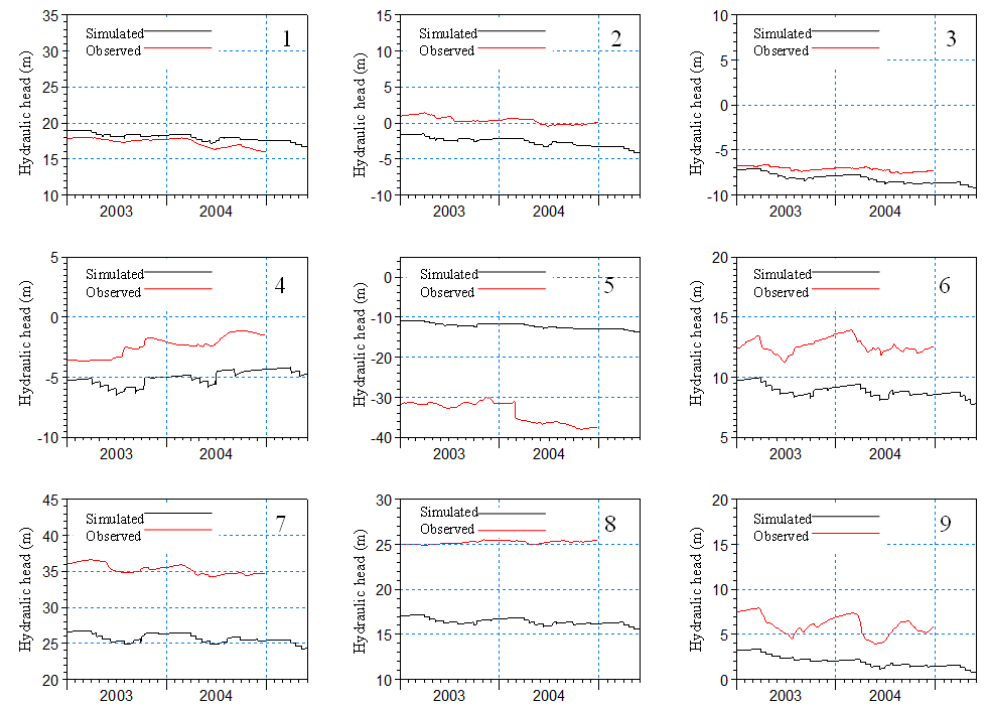
Figure4 Figure 4. Comparison of observed and simulated hydraulic heads for selected wells (validation